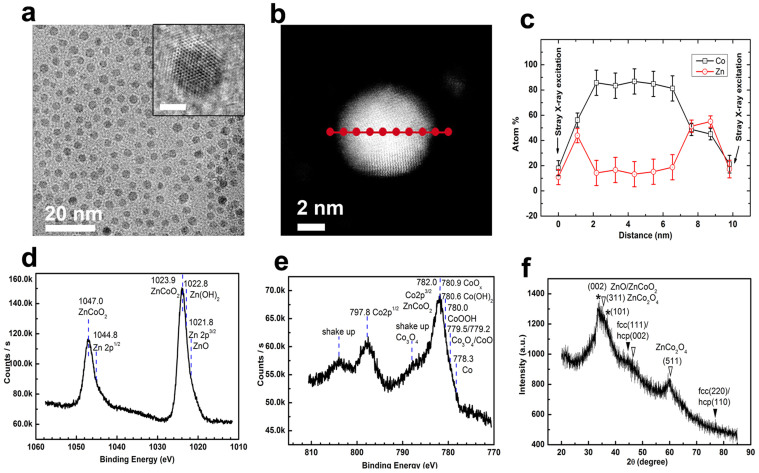
Wide-viewed TEM image (a), HR-TEM image of one single particle(a: inset, scale bar: 2 nm), STEM-HAADF image of one single particle (b), point-by-point EDX scanning of one single particle (c), high energy resolution XPS for Zn (d), high energy resolution XPS for Co (e) and XRD (f) of CoZn@Zn(1-x)CoxOy nanohybrids synthesized using all NMP-phased reaction systems.JCPDS No for XRD analysis: fcc Co, 15-0806; hcp Co, 05-0727; wurtzite ZnO, 36-1451; spinel ZnCo2O4, 23-1390. In XRD (vi), : the corresponding metallic phases;  and *: the corresponding metal oxides.